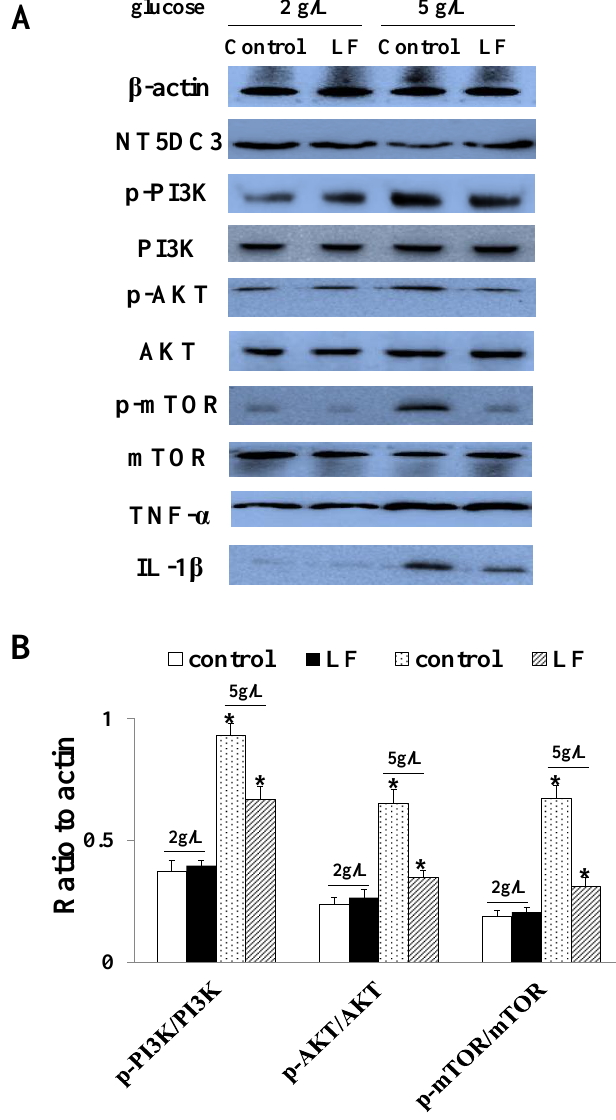
Figure 2. Expression levels of the proteins in NCM460 cells co-cultured with HT29 cells at different glucose concentrations. ( A ) Protein bands of NT5DC3, p-PI3K, PI3K, p-AKT, AKT, p-mTOR, mTOR, TNF- α, and IL - 1β, determined via Western blotting. ( B ) Statistical analysis of the p-PI3K/PI3K, p-AKT/AKT, and p-mTOR/mTOR ratios. The data are presented as mean ± SD, * p < 0.05 compared with the control group. This experiment was repeated three times ( n = 3).